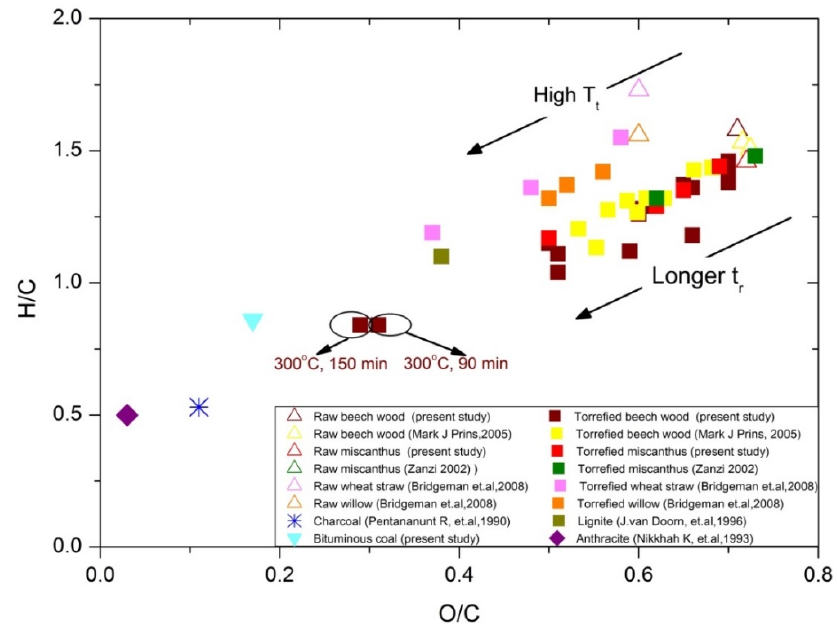
Figure 7. Van-Krevelen diagram for coals, charcoal, raw and various torrefied biomasses, torrefaction temperature (T t ) and residence time (t r ).